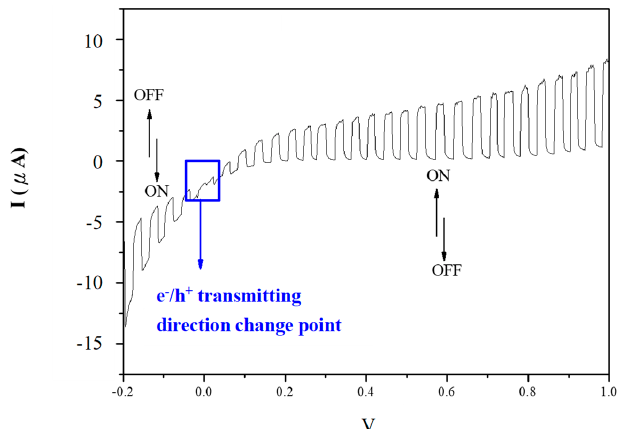
Figure 11. Linear sweep voltammetry curve for the C–TiO 2 photocatalytic film obtained in 200% glucose aqueous solution.